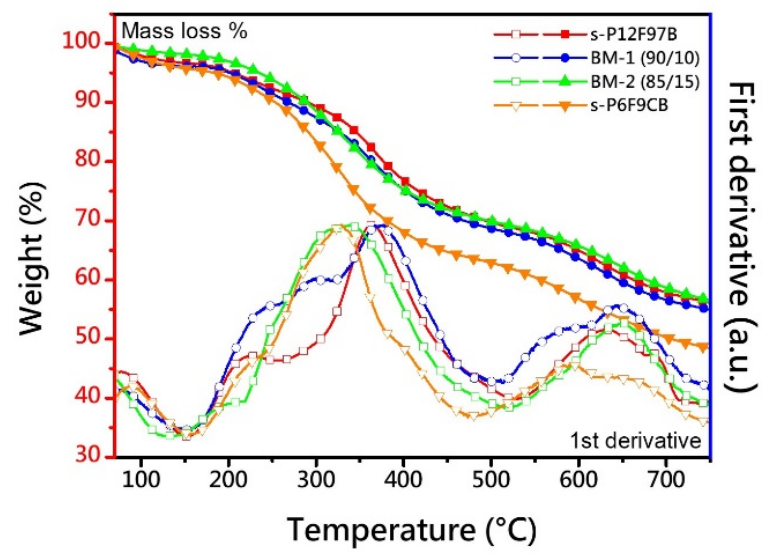
Figure 3. Thermogravimetric analysis curves (left) with normalized first derivative (right) of ionomers and BM ‐ X membranes.